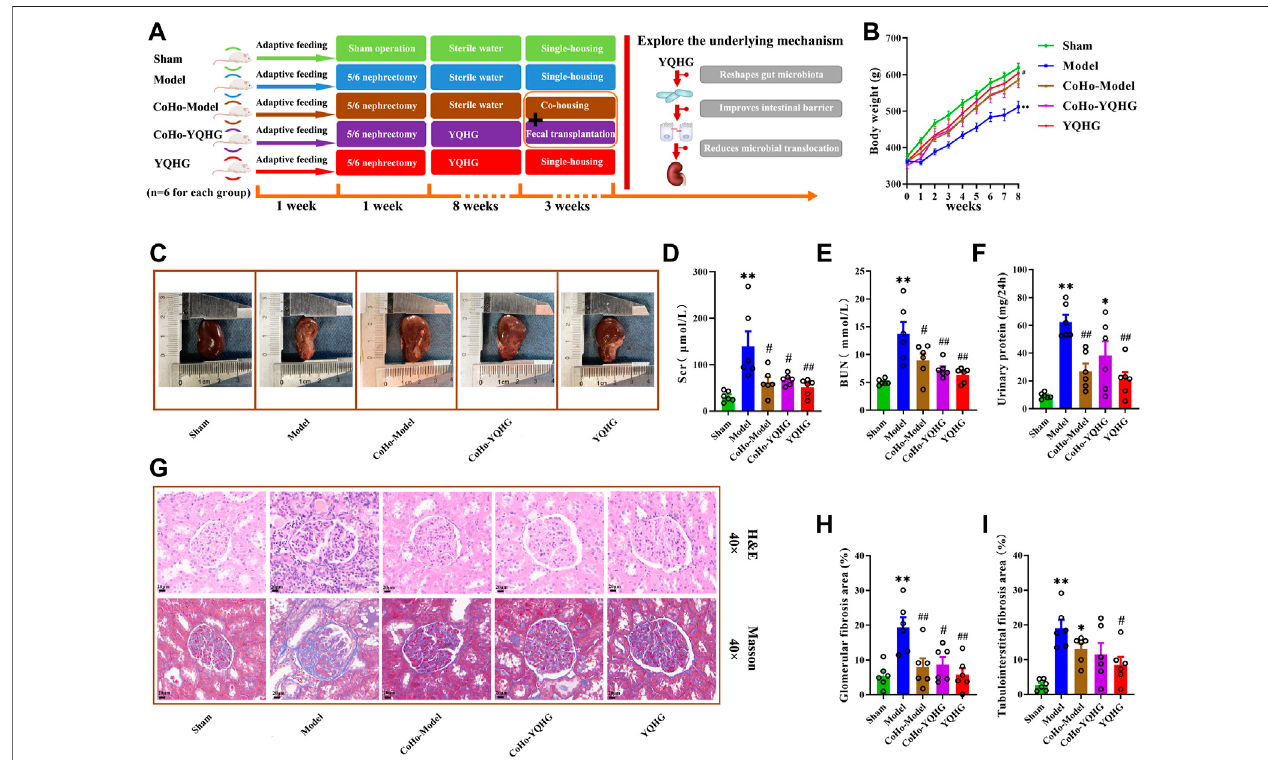
FIGURE 7 | Receiving gut microbiota from YQHG-treated rats improves renal function and fi brosis. (A) Experimental design. (B) The body weight of the rats was measured. (C) The kidney of the rats was photographed. (D – F) Effects of fecal transfer (transplant) from YQHG-treated rats on Scr, BUN, and urinary protein levels. (G) Representative images of H&E (40 × Magni fi cation, Scale bar 20 μ m) staining and Masson (40 × Magni fi cation, scale bar 20 μ m) staining of renal tissues. (H,I) Quantitative analysis of glomerular fi brosis area and tubulointerstital fi brosis area based on Masson staining. All data are expressed as means ± SEM. For normally distributeddata(bodyweight,Scr,BUN,urinaryprotein,glomerular fi brosisarea,tubulointerstital fi brosisarea),one-wayANOVAfollowedbyTukey ’ stestwasused.* p < 0.05, ** p < 0.01 vs. the sham group; # p < 0.05, ## p < 0.01 vs. the model